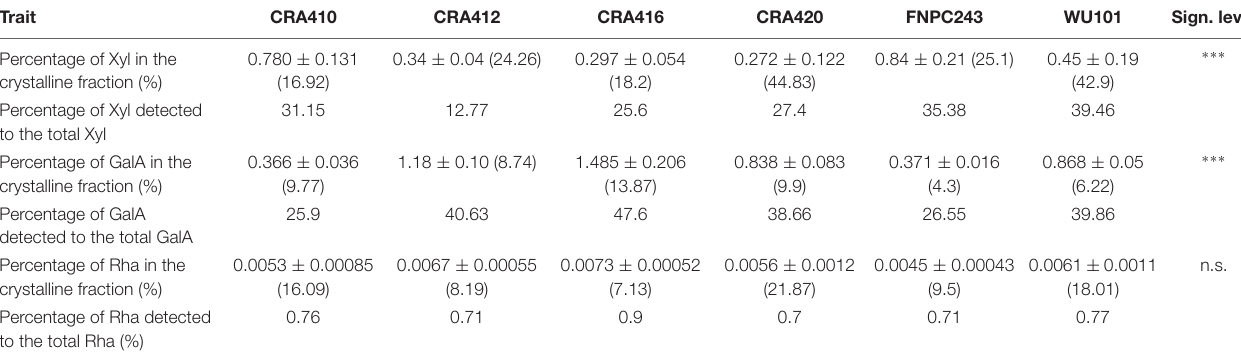
TABLE 4 | Content of xylose (Xyl), galacturonic acid (GalA), and rhamnose (Rha) detected in the crystalline fraction of the six hemp